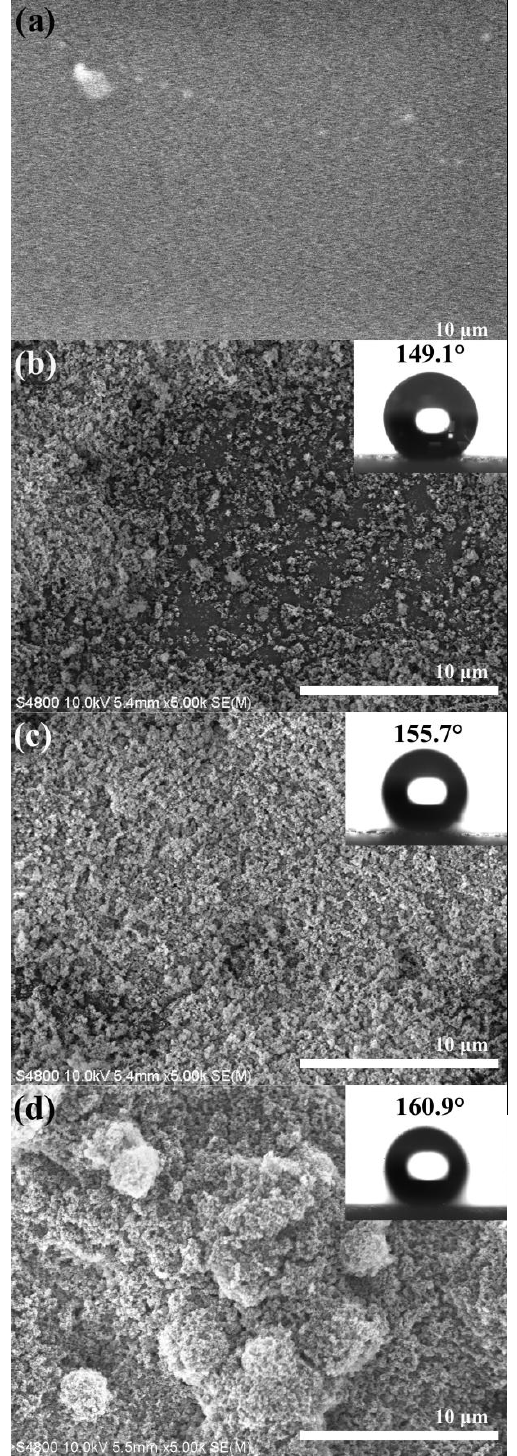
Figure 3. Micromorphology and CA of ( a ) adhesive-coated filter paper, ( b ) P 40 -coated filter paper, ( c ) P 40 –P 4 -coated filter paper, ( d ) P 40 –P 4 –P 0.4 -coated filter paper. Because surface roughness is the primary factor in constructing a superhydrophobic